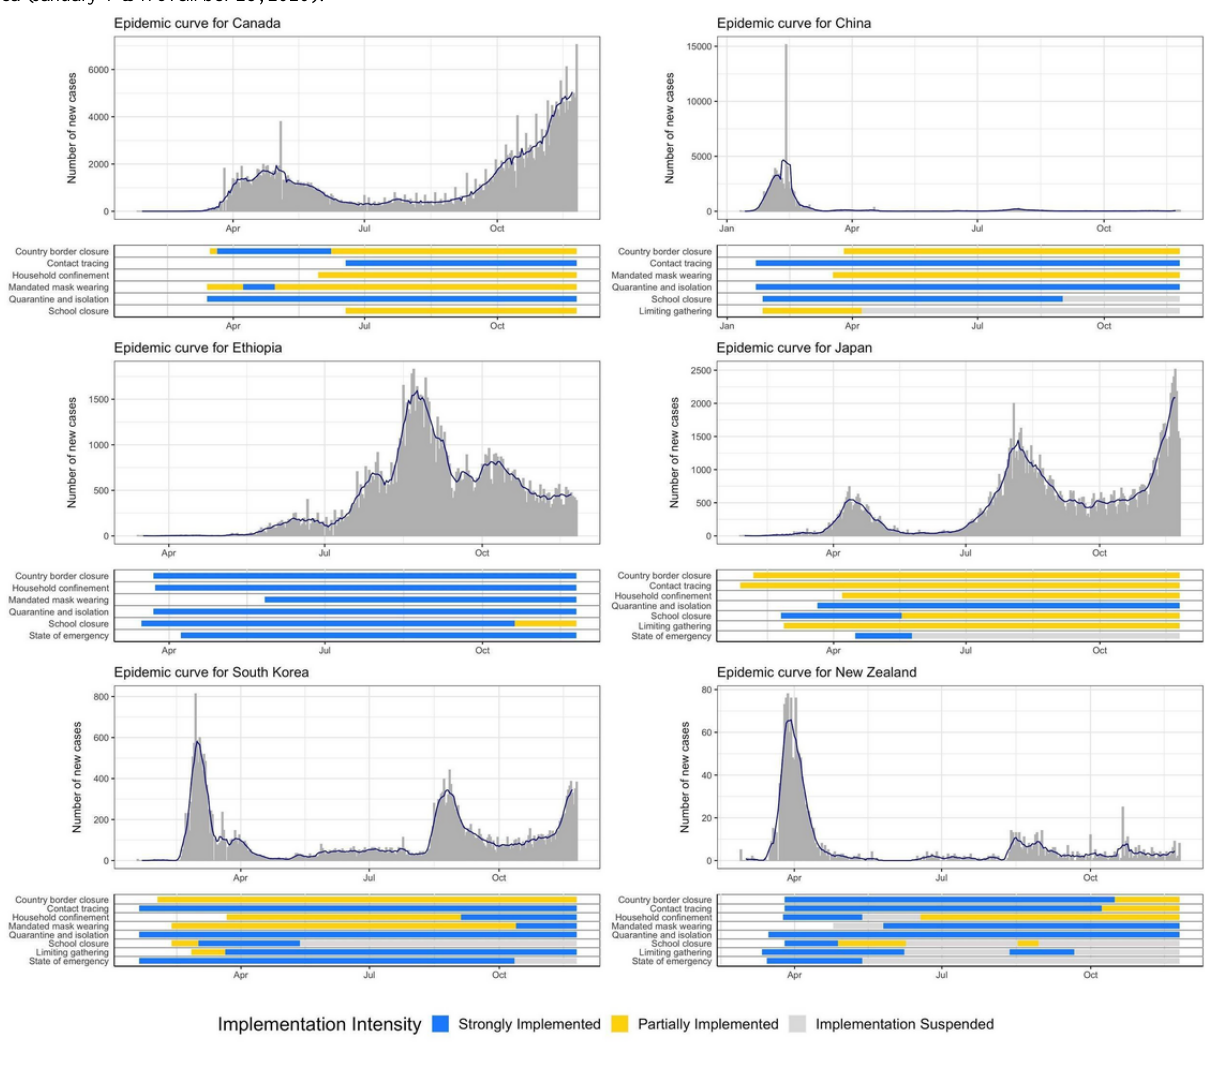
Figure 1. COVID-19 epidemic curves and public health and social measure timelines for China, Canada, Ethiopia, Japan, New Zealand, and